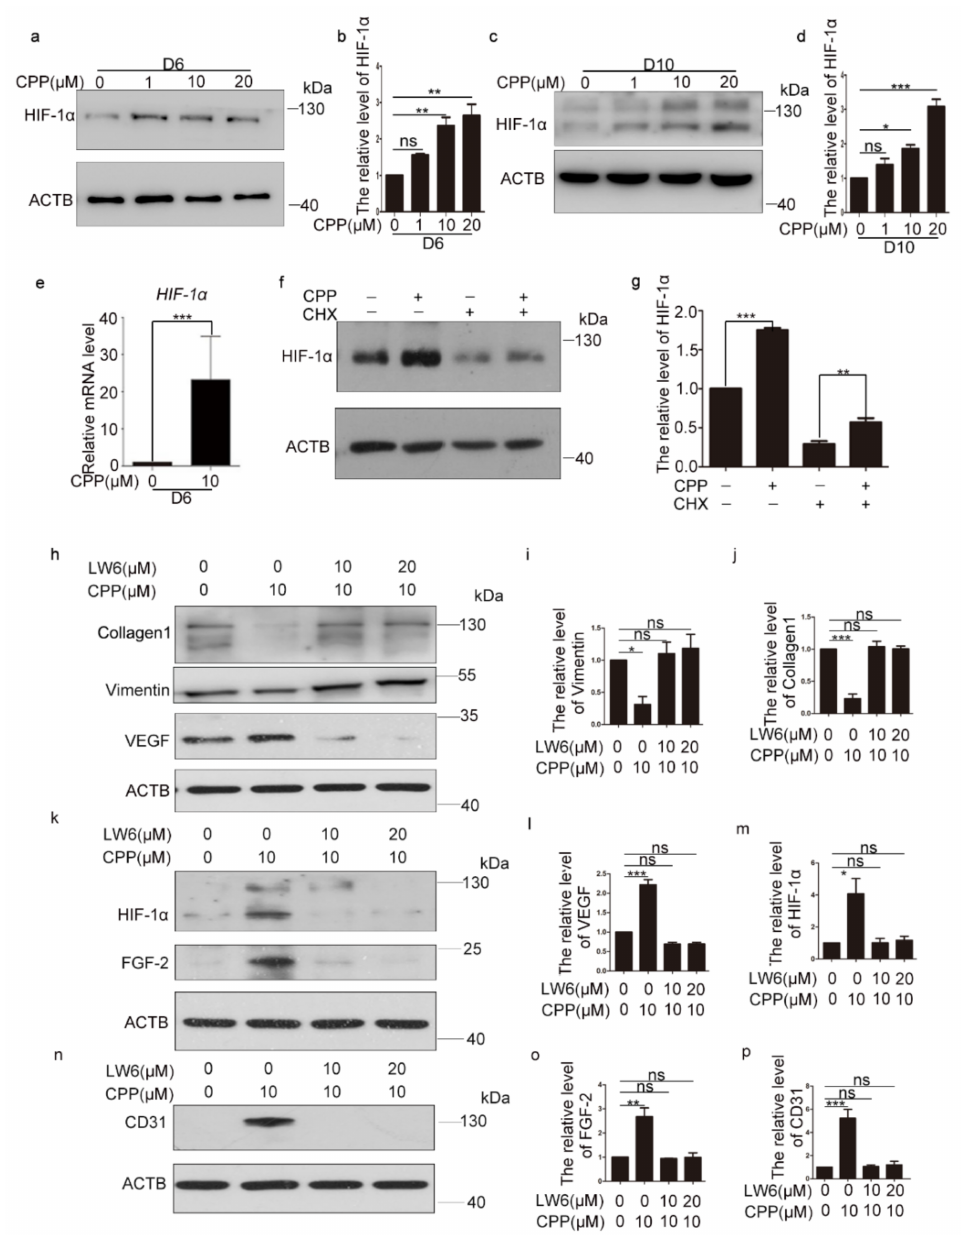
Figure 1. CPP induces the differentiation of HDFs into vascular endothelial cells by increasing levels of HIF-1 α . ( a – d ) HDFs were treated with CPP (0, 1, 10 or 20 µ M) for 6 days (D6) or 10 days (D10), after which Western blot analysis was used to measure the protein level of HIF-1 α . β -actin (ACTB) was used as a loading control. ( e ) HDFs were treated with CPP (0 or 10 µ M) for 6 days (D6), after which qRT-PCR was used to detect the mRNA level of HIF-1 α . ( f,g ) In the presence or absence of cycloheximide (CHX, 10 µ g/mL), HDFs were treated with 10 µ M CPP for 48 h, after which the protein level of HIF-1 α was detected by Western blot. β -actin (ACTB) was used as a loading control. ( h – p ) HDFs were pretreated with LW6, an inhibitor of HIF-1 α , for 12 h, and then treated with CPP (10 µ M) for 6 days (D6), and protein levels of CD31, HIF-1 α , VEGF, FGF-2, Collagen 1 and Vimentin were determined by Western blot. β -actin (ACTB) was used as a loading control. Data are presented as means ± SEM, * p < 0.05, ** p < 0.01, *** p < 0.001, n =